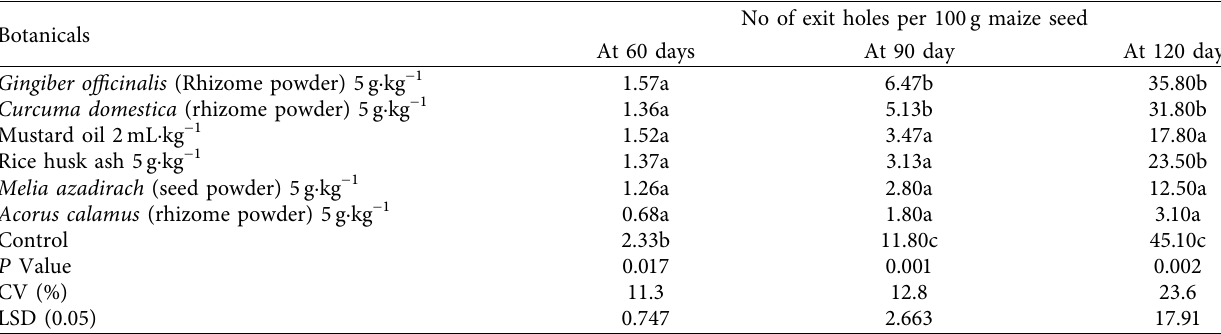
Table 2: Efect of diferent botanicals on exit hole numbers caused by maize weevil ( Sitophilus zeamais Motsch.) in maize seeds.